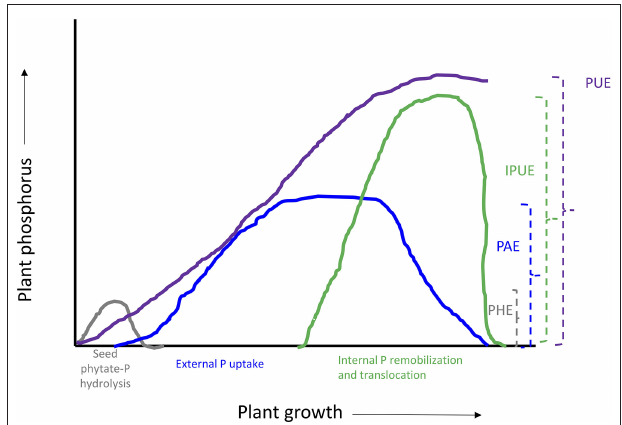
FIGURE 3 | Schematic representation of plant phosphorus use efficiency and different components. PUE, phosphorus use efficiency; IPUE,